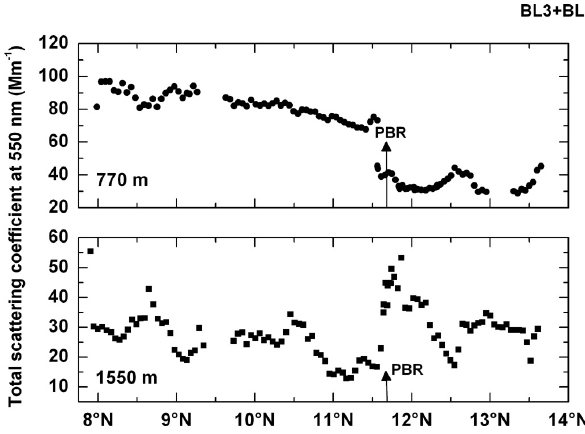
Fig. 12. Extended longitudinal variation of σ tsc during BL4 and BL6 (eastwards from CHN and westwards from PBR) over central BoB at 770 (upper panel) and 1550m (lower panel) altitude. Solid line represents best linear fit illustrating eastward increasing trend in σ tsc values at 770m.